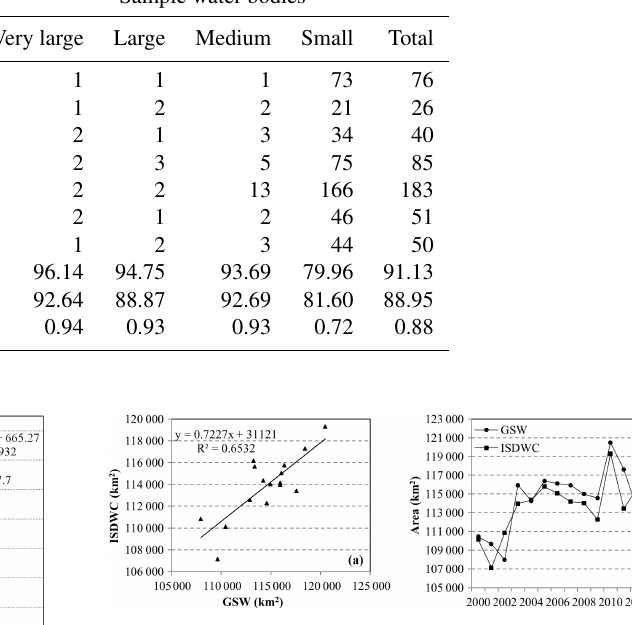
Figure 4. Comparison of the time series annual ISWDC and GSW permanent water bodies of the whole of China from 2000 to